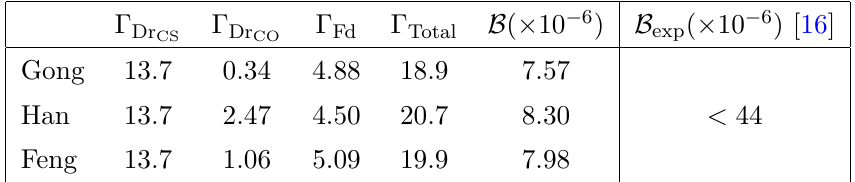
Table 3 . Decay widths of Z → Υ(1 S )+ X (in units of KeV). The subscripts “ Dr 00 and “ Fd 00 refer to the direct-production processes and feed-down effects, respectively. m b = 4 . 75 GeV and µ r = m Z / 2 .